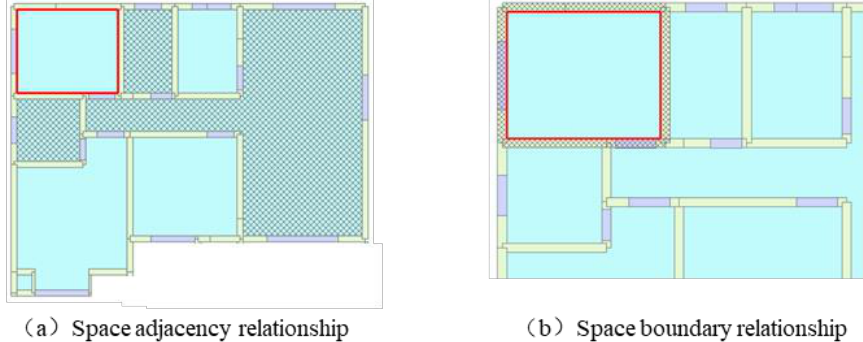
Figure 15. Query and visualization of relationships involved in indoor space.